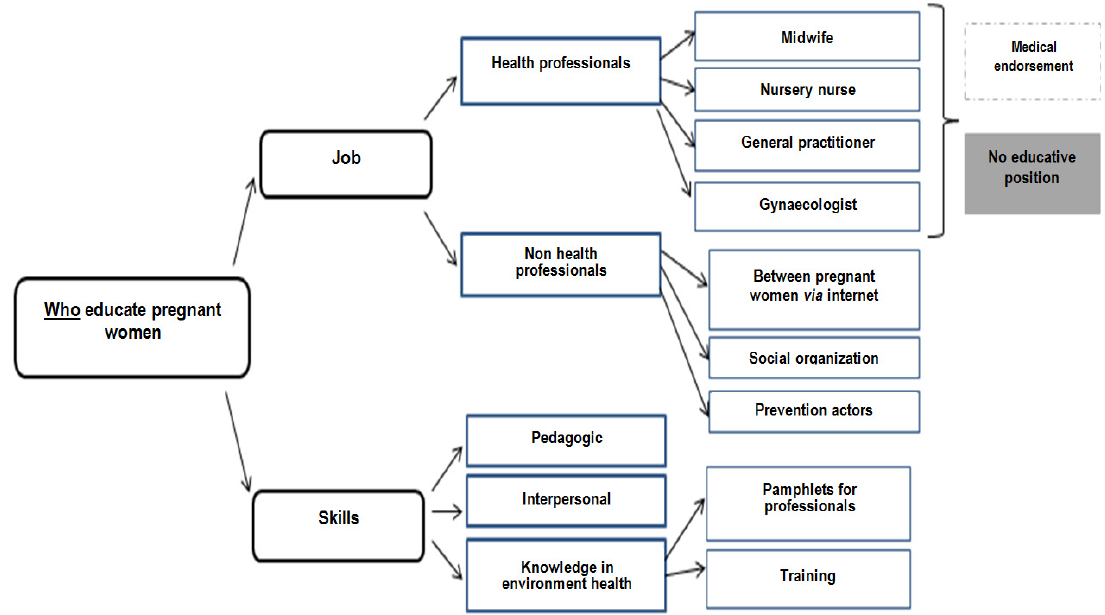
Figure 1. Perception of professionals on “who educate pregnant women”.